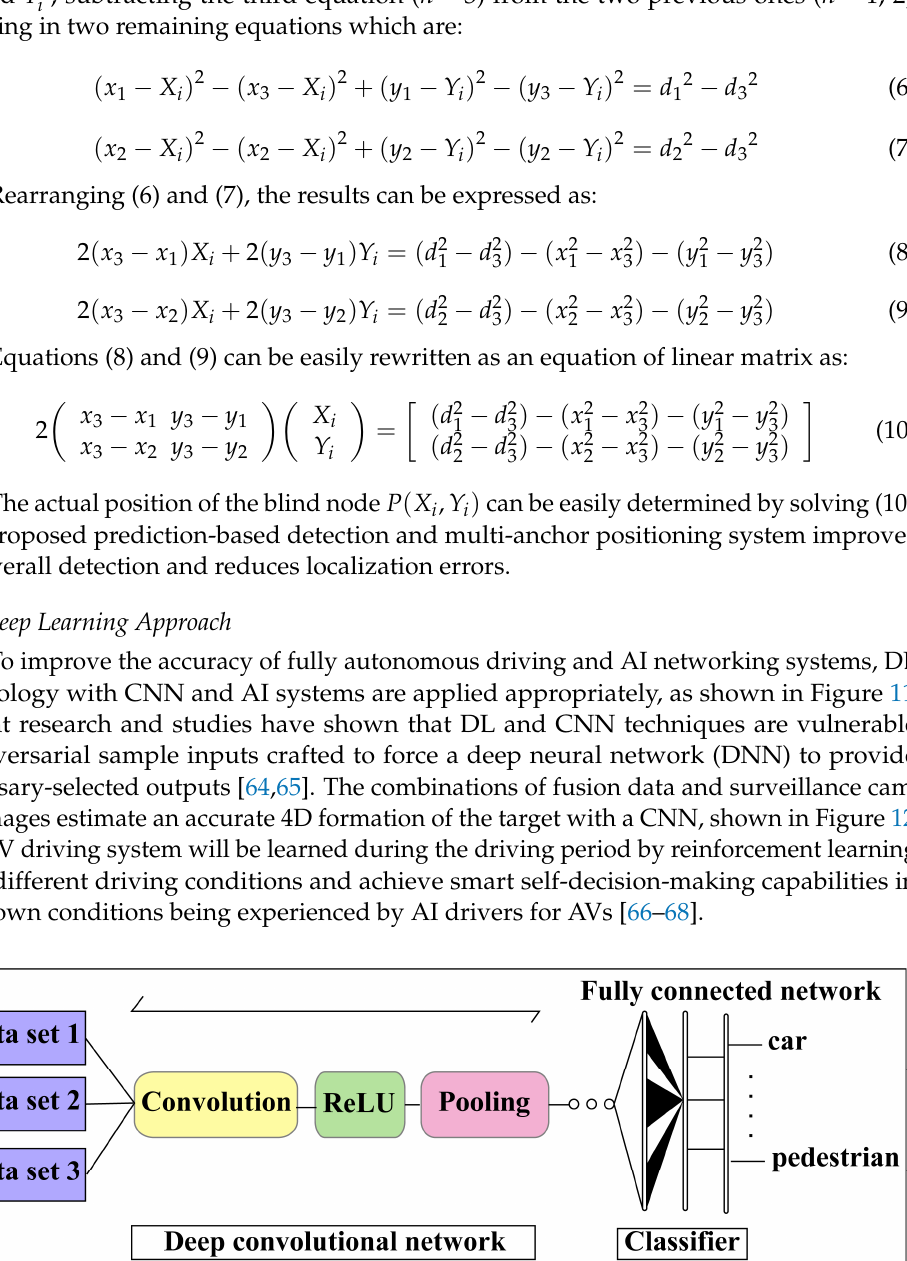
Figure 12. AI algorithm and CNNs architectural block diagram for surveillance camera and car sen- sors integrated detection system in FSCDS.